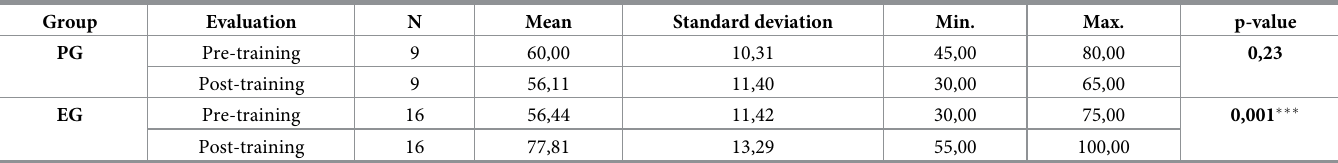
Table 2. Percentage of correct answers in the PPST per group